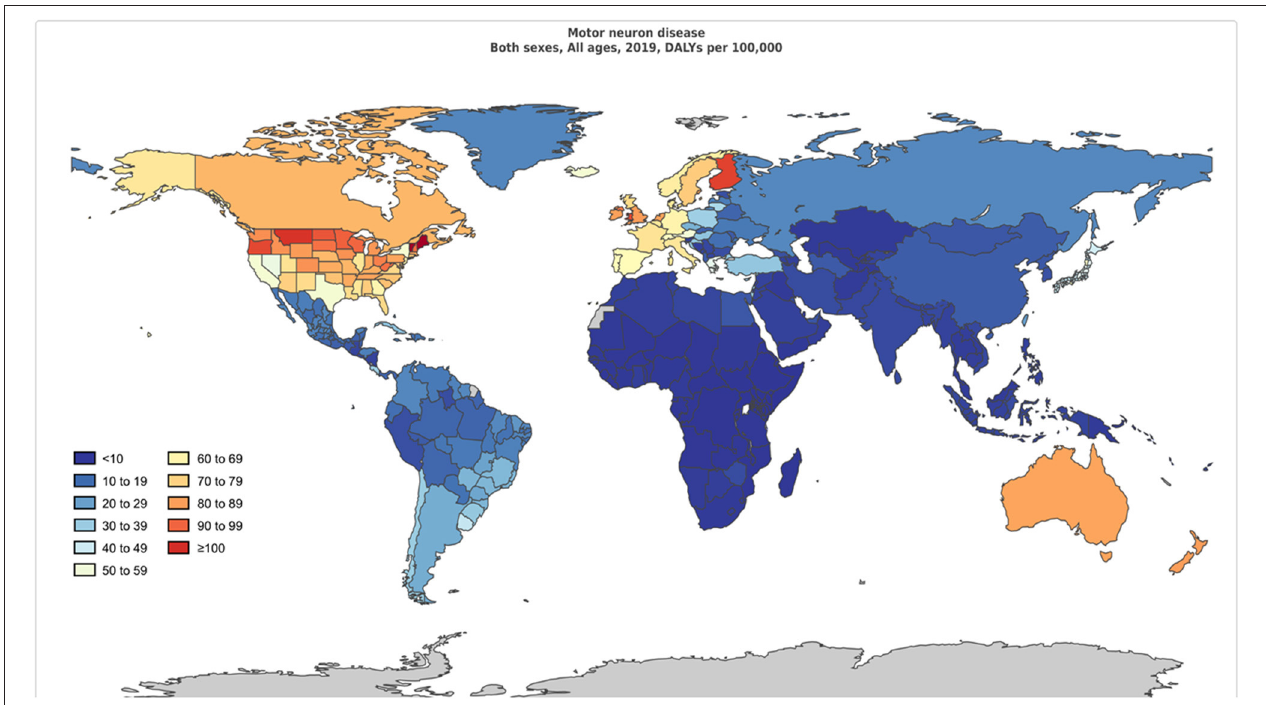
FIGURE 1 | Age-standardized disability-adjusted life-years per 100,000 population of motor neuron diseases by region for both sexes, 2019.